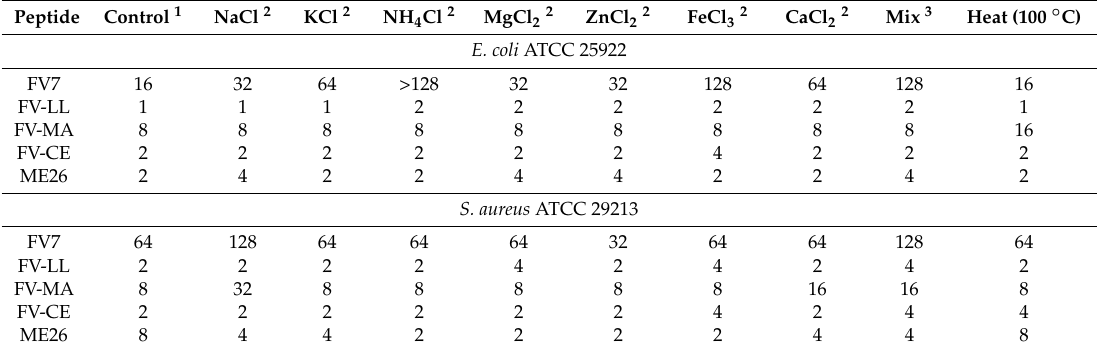
Table 3. MIC values of peptides in the presence of physiological salts and heat with E. coli ATCC 25922 and S. aureus ATCC 29213.